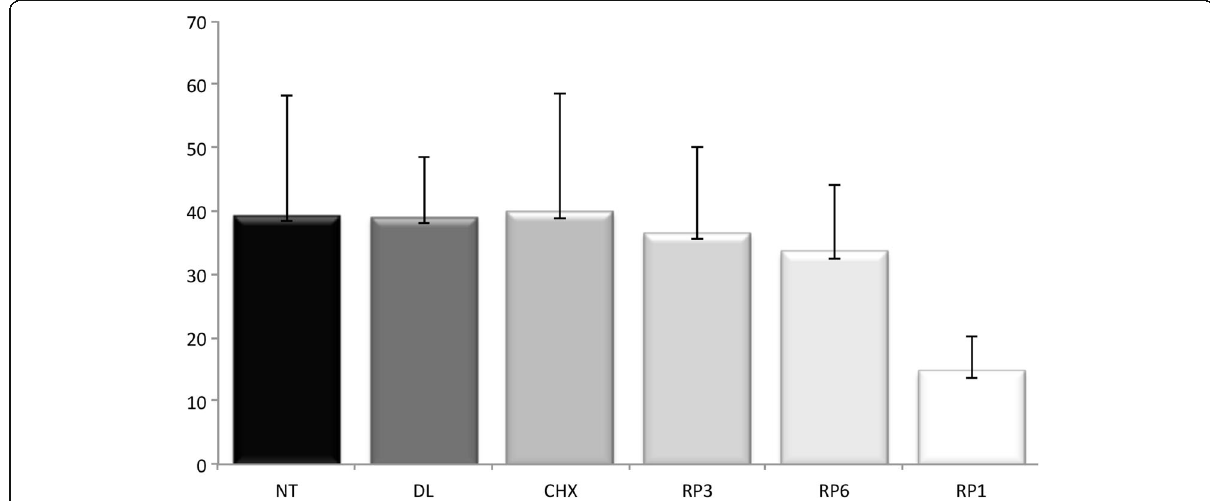
Fig. 3 Microtensile dentin bond strength values in MPa. Kruskal-Wallis test for pairwise comparisons of Brazilian red propolis